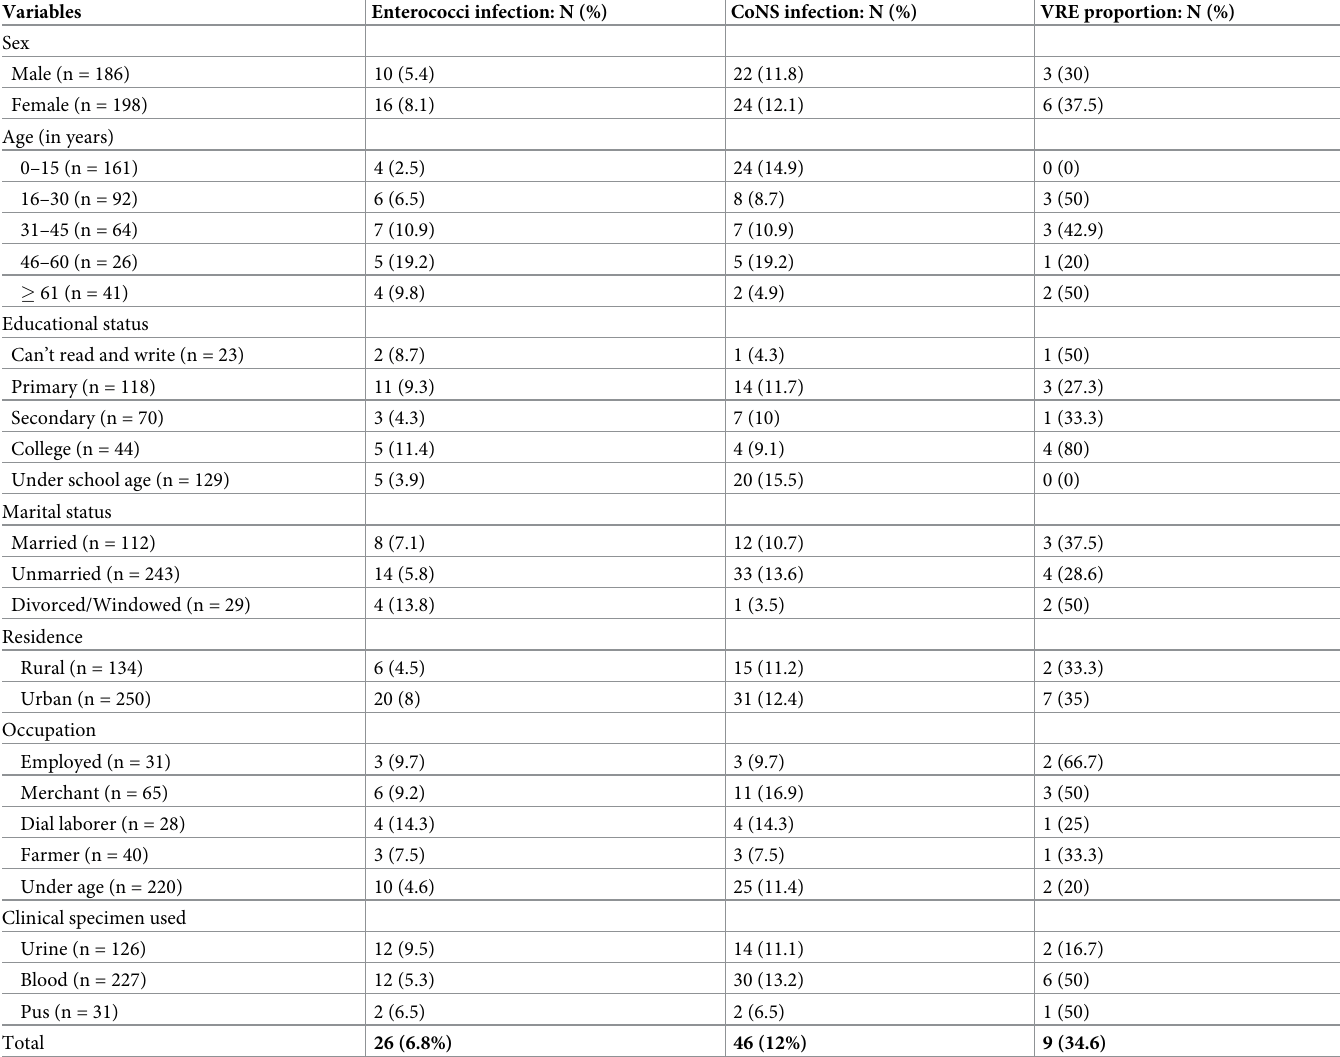
Table 2. Prevalence of Enterococcus spp. and coagulase negative Staphylococcus spp. in relation to different variables among patients attending at FHSCH, Bahir Dar, Ethiopia, 2020. Variables